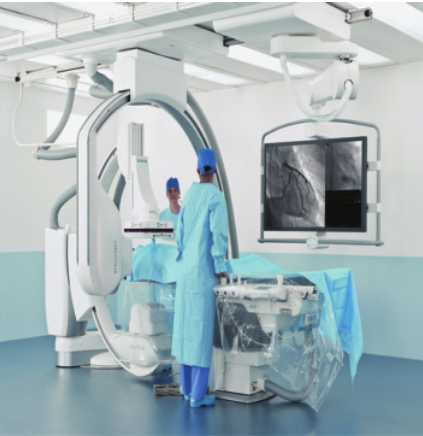
Figure 9: The Artis angiography system, courtesy of Siemens